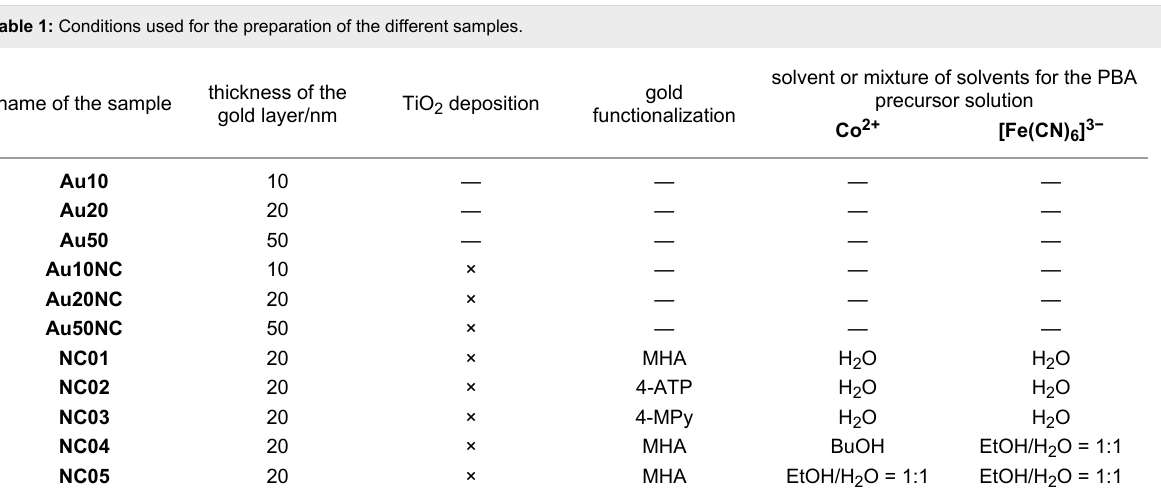
accomplished by using an Innova AFM (Bruker) with NanoDrive v8.02 software. Tapping mode images were with a resonance frequency ranging between 76 and 263